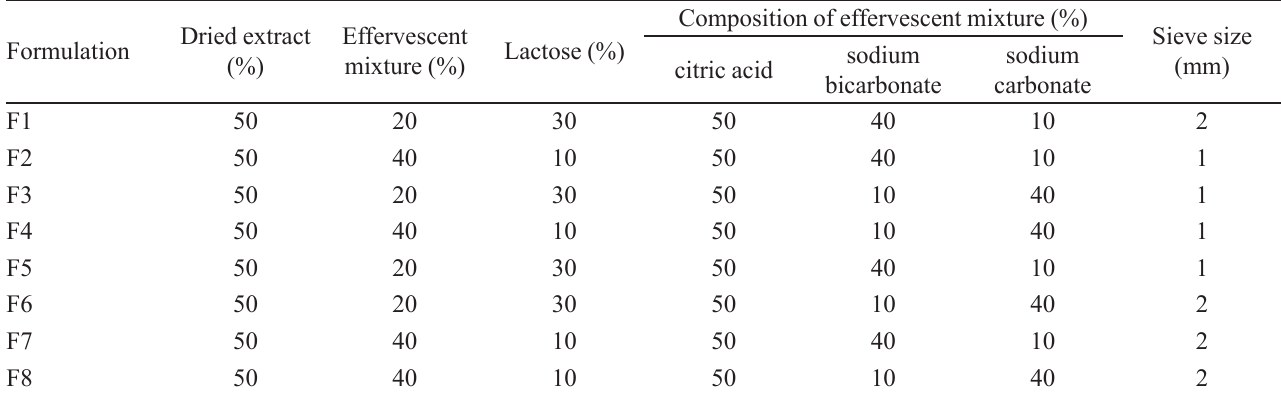
TABLE I - Components used in the effervescent granules of Maytenus ilicifolia , the composition of the effervescent mixture and the sieve size used in the granulation